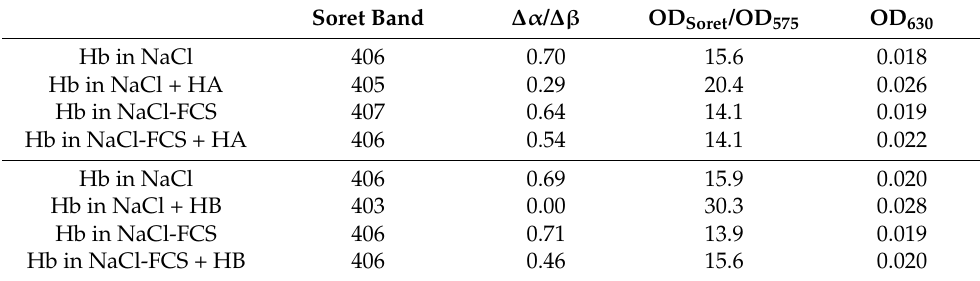
Figure 5. Hennoside-induced changes of Vis spectral characteristic (390–750 nm; zoom region 450–750 nm) of hemoglobin in solution. ( a , c ) 500 µ g/mL of hennoside A; ( c , d ) 500 µ g/mL of hennoside B; ( a , b ) diluent 0.9% NaCl (NaCl); ( c , d ) diluent 0.9% NaCl containing 10% FCS (NaCl-FCS). Table 1. Effect of 500 µ g/mL of hennosides A and B on Vis spectral characteristics of